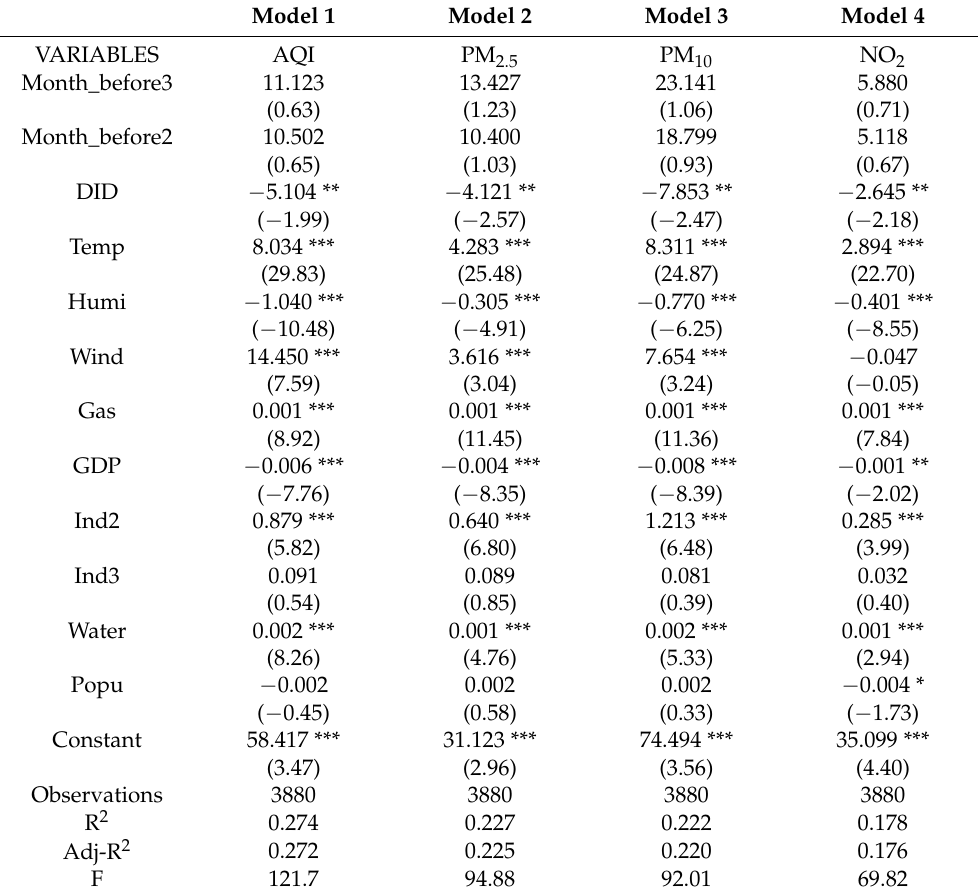
Table 7. Parallel trend test